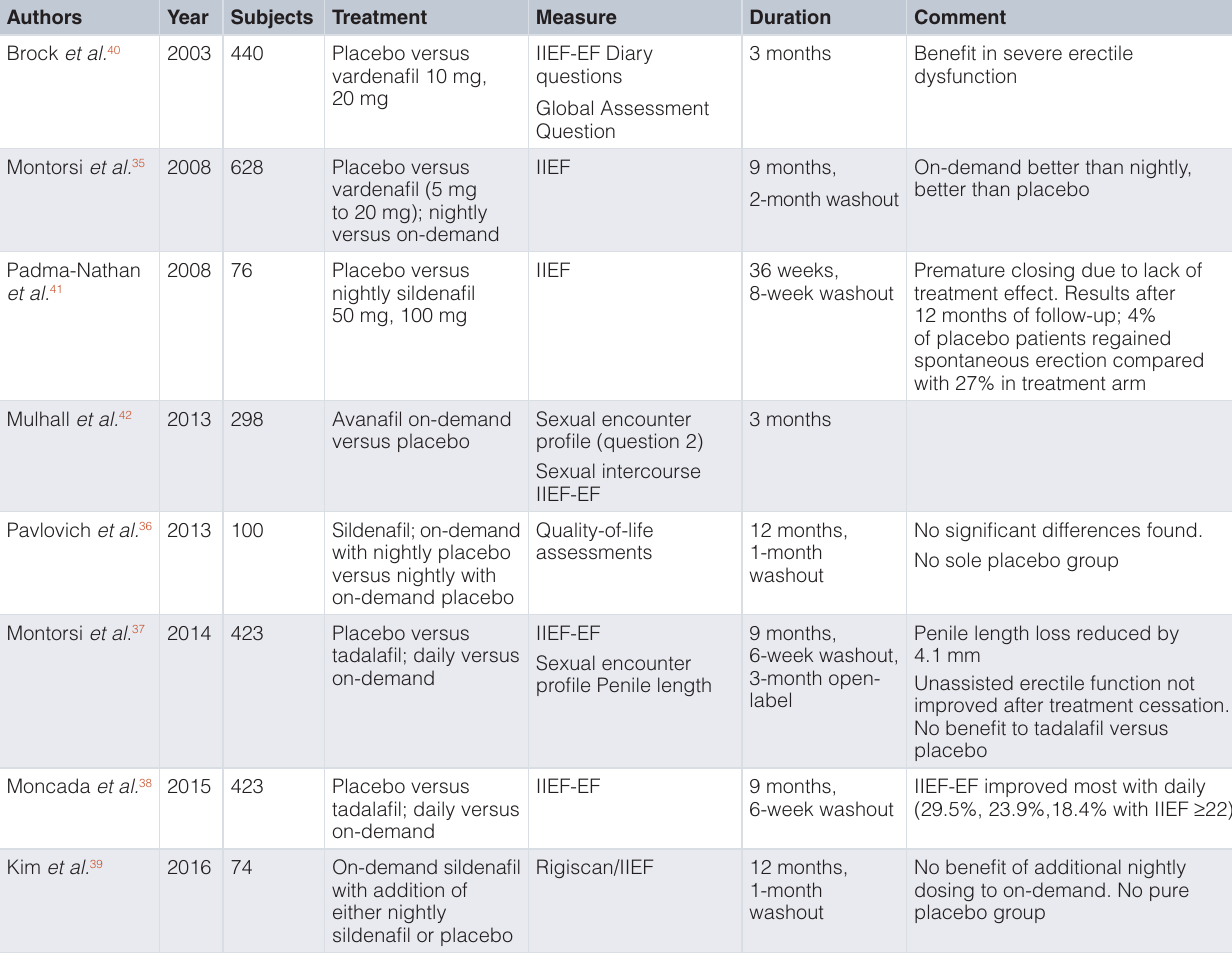
Table 1. Randomised trials of oral phosphodiesterase type 5